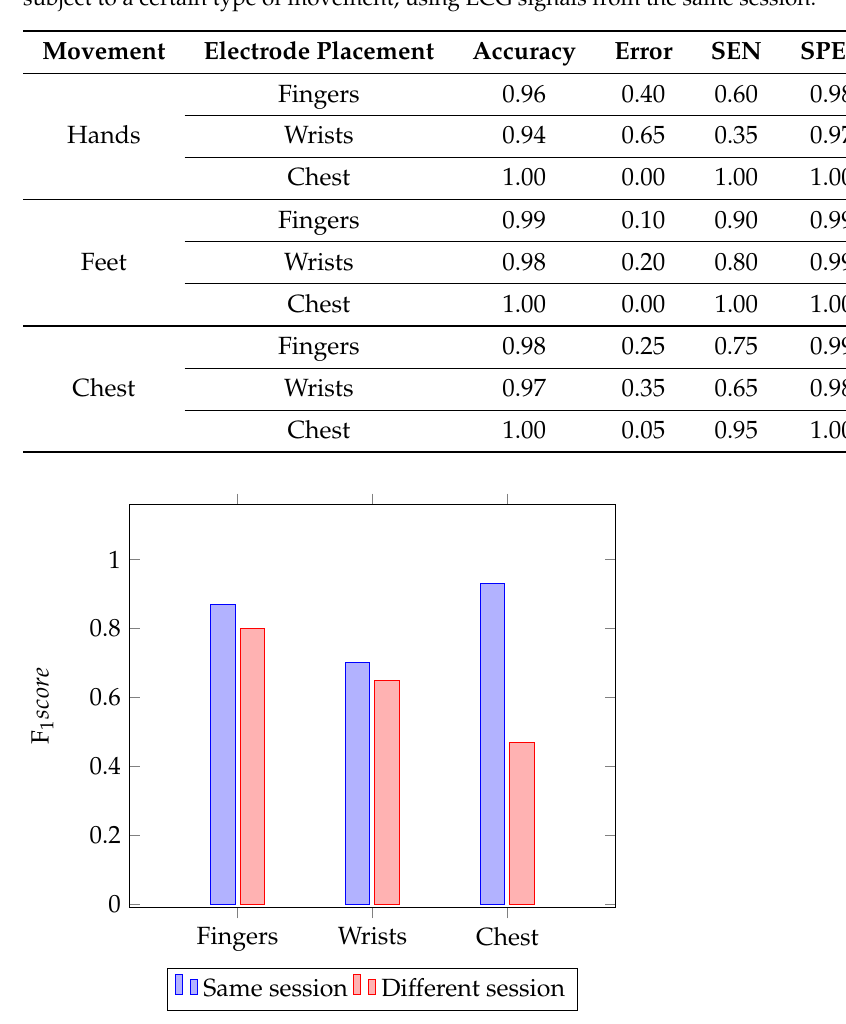
Table 1. Evaluation of accuracy, error, sensitivity, specificity and F 1 score for each electrode placement, subject to a certain type of movement, using ECG signals from the same session.